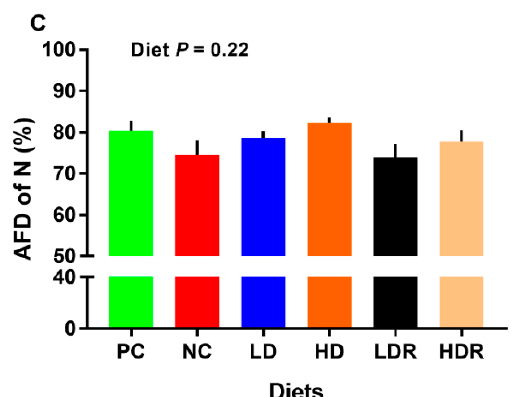
Figure 1. Nutrients’ digestibility in pigs fed with low-protein diets supplemented with a corn-expressed phytase. ( A ) apparent fecal digestibility (AFD) of calcium (Ca), ( B ) AFD of phosphorus (P), ( C ) AFD of nitrogen (N). Pigs are grouped based on their dietary treatments: PC (positive control): normal protein, adequate Ca and available phosphorous (aP), no corn-expressed phytase (CEP) added; NC (negative control): low protein, adequate Ca and aP, no CEP added; LD: NC + CEP added